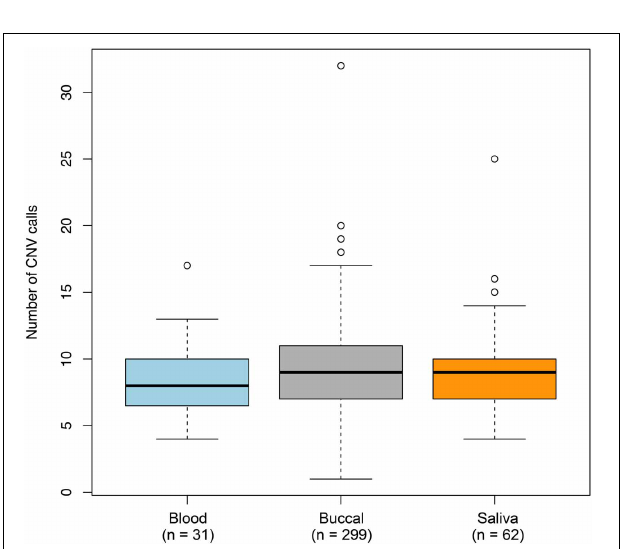
calls in a given genotyping batch are represented by a white box and black bar, respectively. The whiskers are drawn to 1.5 times the interquartile range; circles are drawn to represent individuals with a total number of CNV calls beyond that range.